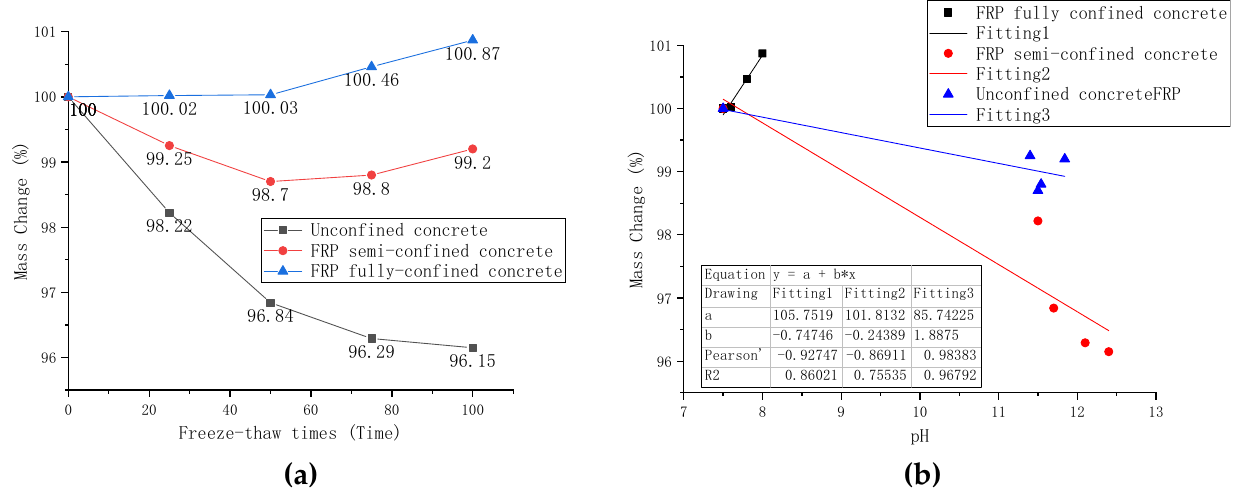
Figure 7. Mass change: (a) the relationship between mass change and the number of freeze–thaw cycles; (b) the relationship between mass change and